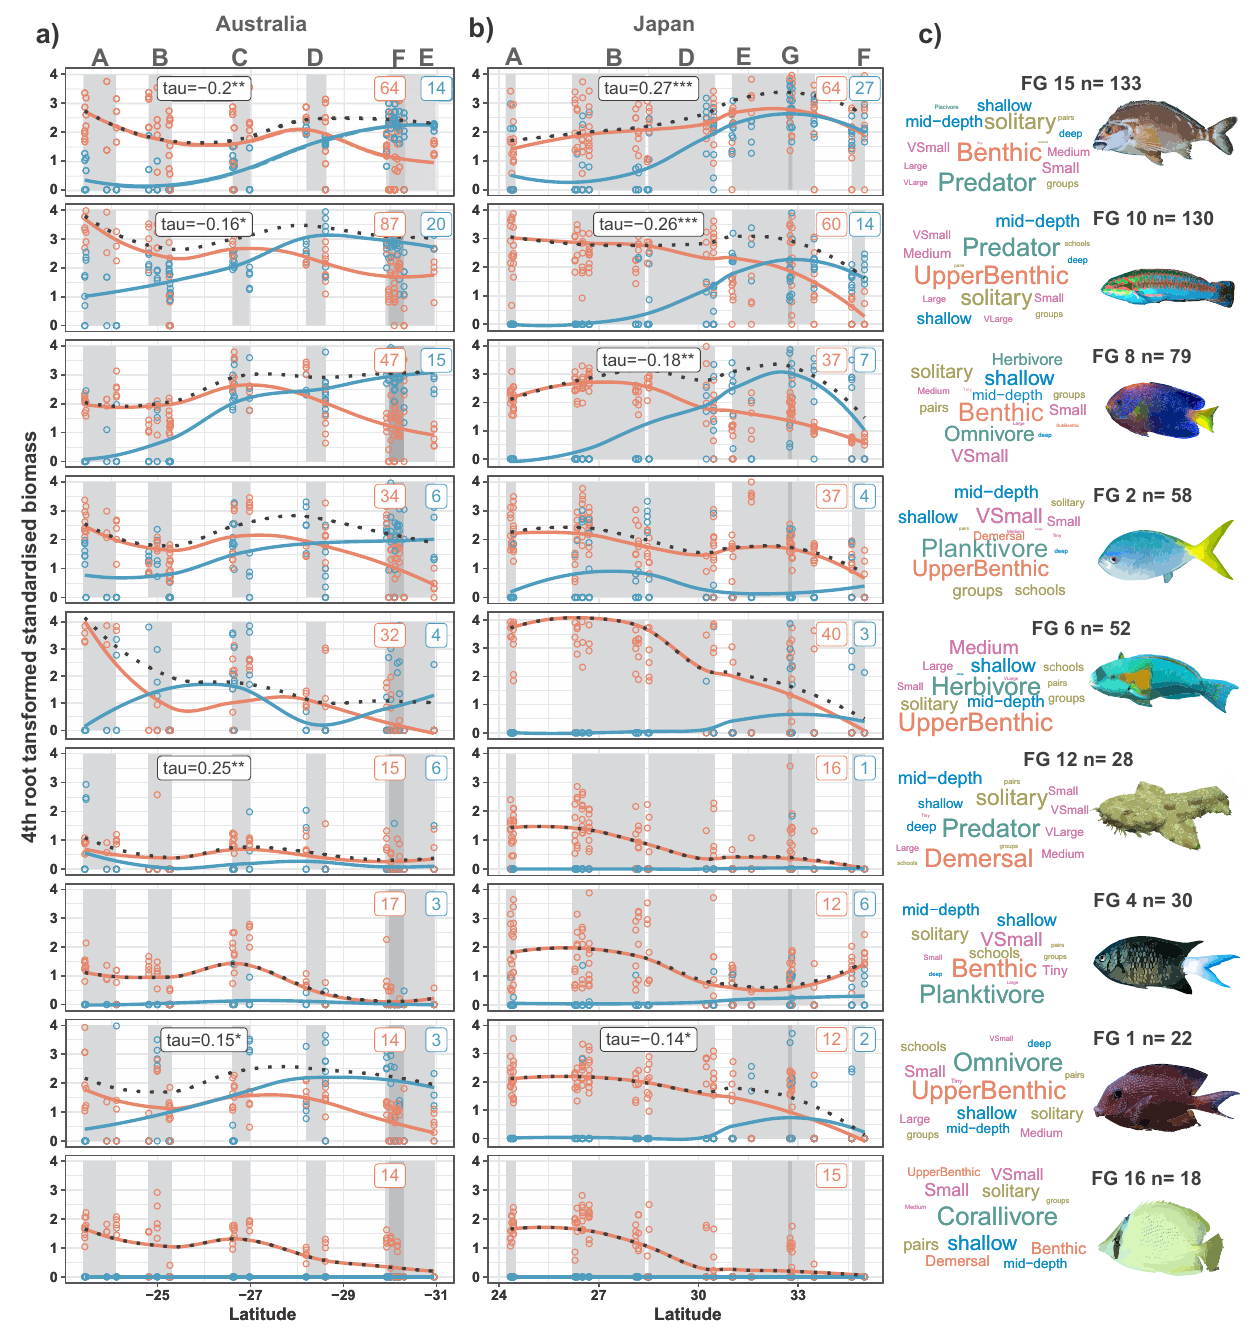
Fig. 2 | Changes in functional group biomass over latitude. Biomass trends of tropical (red) and temperate species (blue) in ( a ) Australia and ( b ) Japan, from ( c ) differentfunctionalgroups.Loesssmoothersvisualisetrendsoverlatitudeforeach thermalguildandtotalbiomass(dotted).Greyshaderepresentslatitudinalspansof six zones (A – G) in each region, see Fig. 1. Inset boxes within each latitude plot denote number of tropical and temperate species from each functional group withineachregion.Functionalgroupswithsigni fi cantcorrelationbetweentropical and temperate biomass have Kendall ’ s tau and associated signi fi cance shown (<0.001=***,<0.01=**,<0.05=*).Biomassoutlierdatapoints>4omittedfromplot to aid visualisation but loess curves and correlation still fi tted on full data. Word